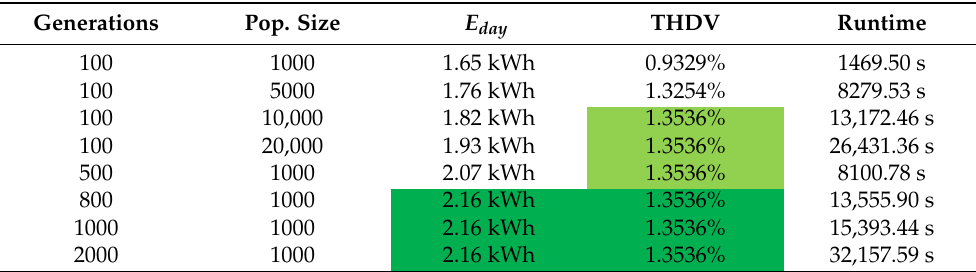
Table 3. Results of the proof of concept for a virtual machine in a predefined scenario. Marked in light-/green are the local respective global optima found by the